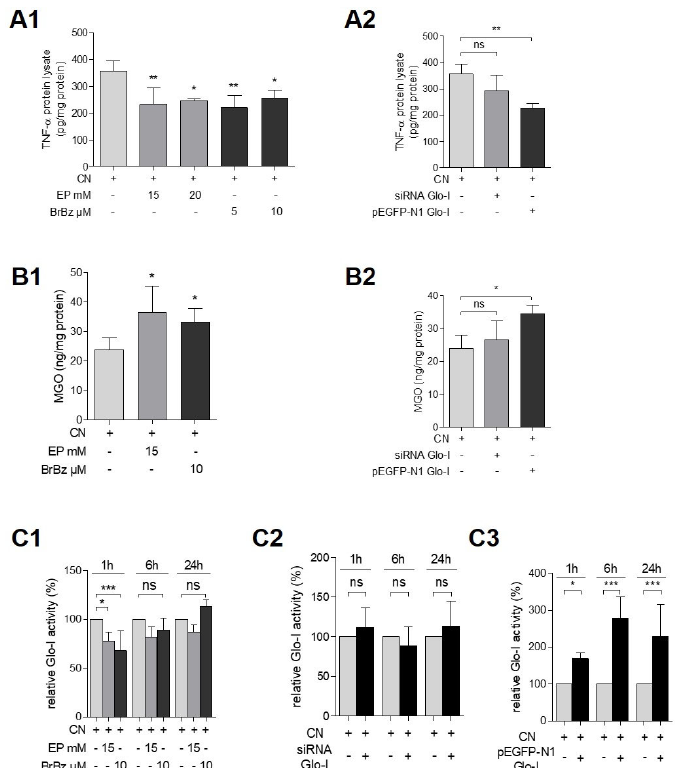
Figure 6. Effect of Glo-I targeting on TNF- α and MGO. ( A1 , A2 ) Effect of pharmacological modulation and Glo-I knockdown or overexpression on TNF- α levels of CN-treated AR42J protein lysates. EP, BrBz ( A1 ) and Glo-I overexpression ( A2 ) significantly decreased CN-induced TNF- α concentrations. Glo-I knockdown did not statistically significantly reduce TNF- α ( A2 ). ( B1 , B2 ) Effect of EP, BrBz, Glo-I knockdown and overexpression on MGO levels of CN-treated cells. EP, BrBz ( B1 ) and Glo-I overexpression ( B2 ) increased MGO compared to CN incubation and thus restored MGO to levels of untreated cells (see Figure 3). GLo-I knockdown revealed no significant impact on MGO ( B2 ). ( C1 – C3 ) Analysis of specific Glo-I activity after co-treatment of CN and EP or BrBz, as well as Glo-I overexpression or knockdown. EP and BrBz significantly reduced Glo-I activity ( C1 ) in CN-treated cells but Glo-I overexpression ( C3 ) resulted in an increase of Glo-I activity. Glo-I siRNA ( C2 ) did not influence Glo-I activity in CN-treated AR42J. Quantifications were calculated of at least three independent experiments and are expressed as mean ± SD. * p < 0.05, ** p < 0.01, *** p < 0.001. EP: ethyl